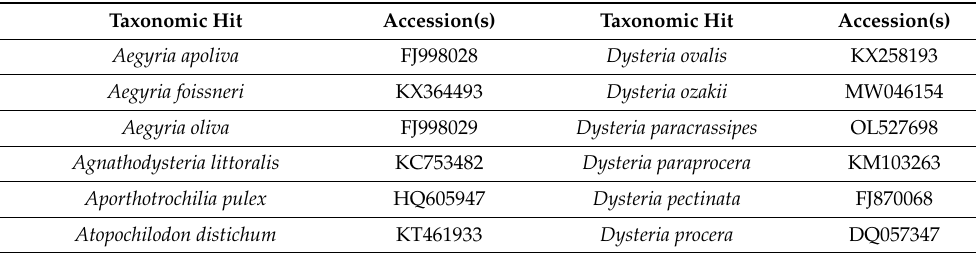
Table 2. NCBI-deposited SSU rDNA sequences of cyrtophorian ciliates from China. One hundred sequences in total belonging to seventy-four cyrtophorian taxonomic